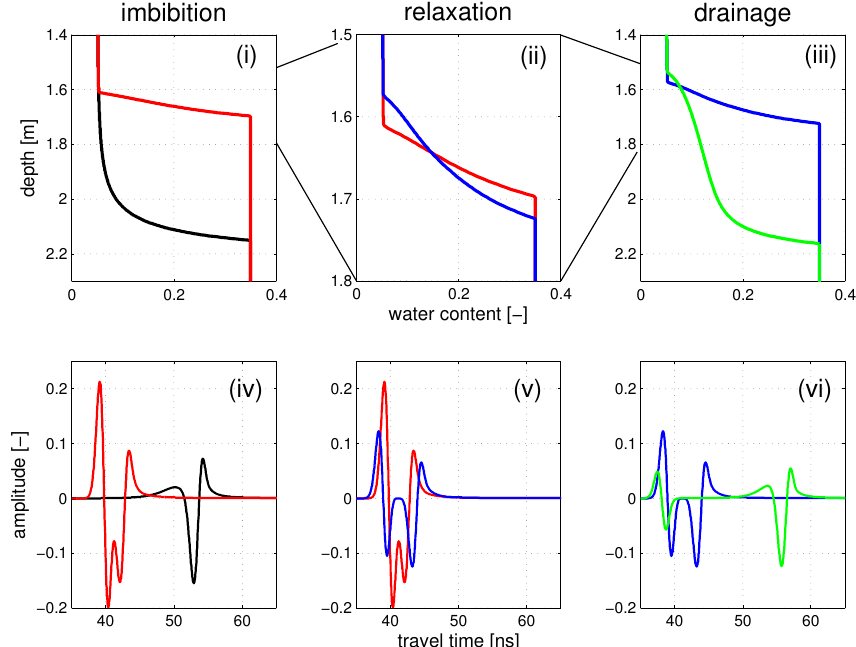
Figure 5. The capillary fringe reflection: distinct hydraulic states (i–iii) for imbibition, relaxation and pumping out as well as the expected corresponding GPR response (iv–vi) . The hydraulic dynamics have been modeled for a typical coarse sand using a similar forcing as in experiment 1. Employed hydraulic parameters can be found in Table